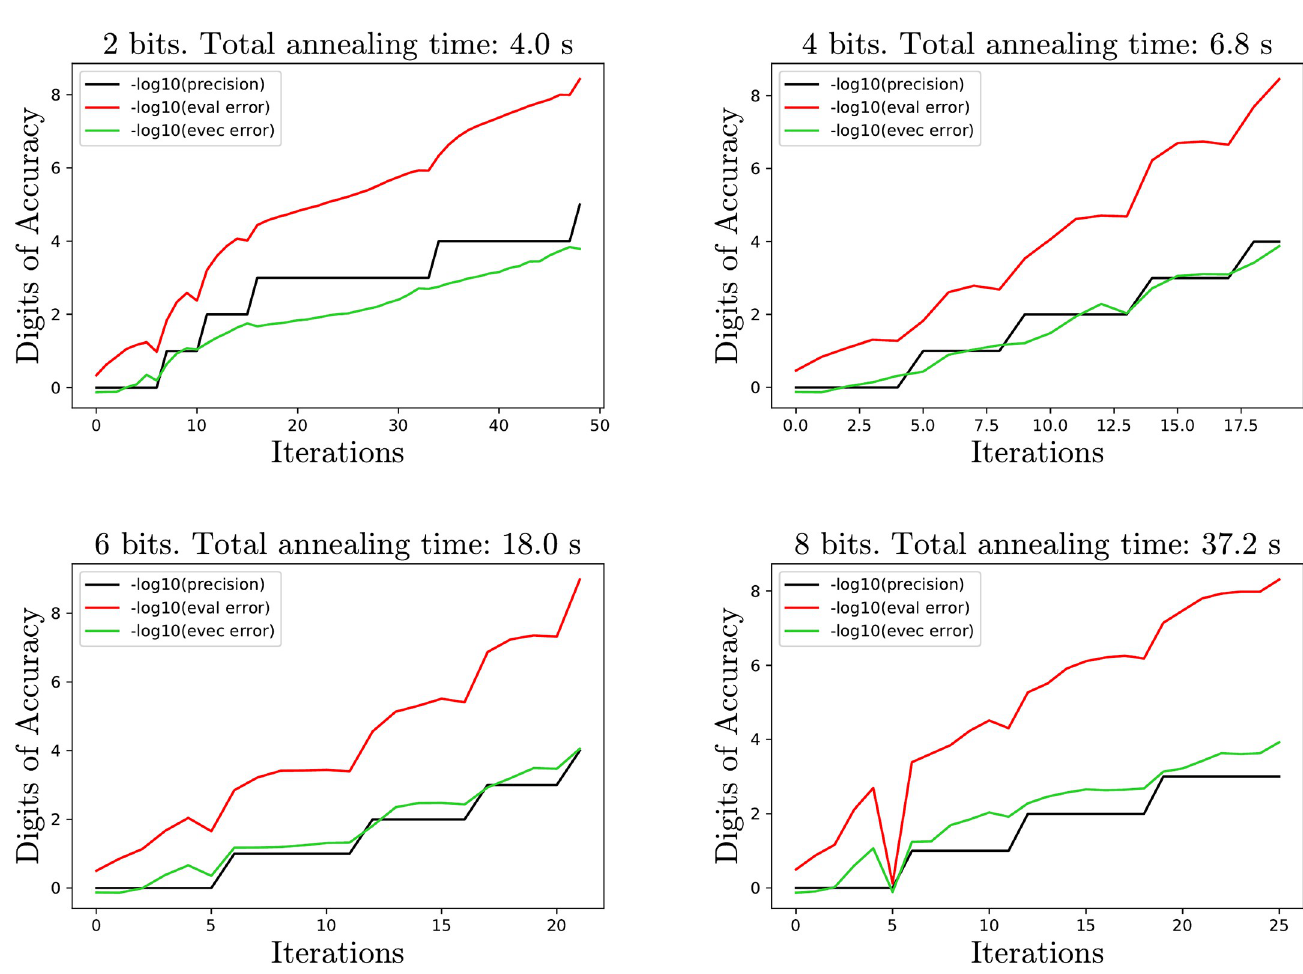
Fig 3. Error plots for generalized eigenvalue problem on two 48 × 48 mesh matrices.